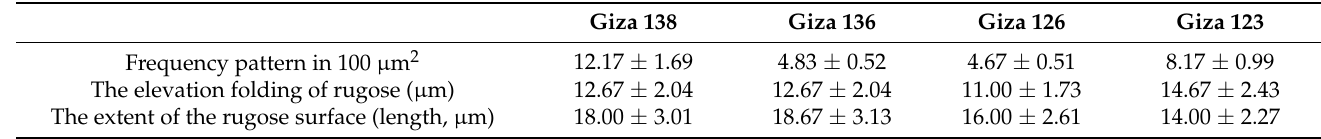
Table 1. The seed coat characteristics of four Egyptian six-rowed barley ( Hordeum vulgare L.) cultivars (Giza 123, Giza 126, Giza 136, and Giza